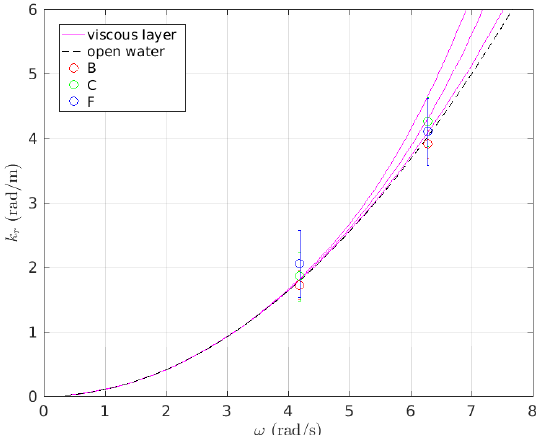
Figure 6. Wave number in ice k r versus wave frequency ω . Average results from three test series are shown as circles with error bars. Also included are theoretical results based on the viscous layer theory [34], computed for the ice thickness in each of the three test series (magenta lines), and linear theory for open water (dashed black line). Viscous layer curves used an effective viscosity of 0.02 m 2 /s.